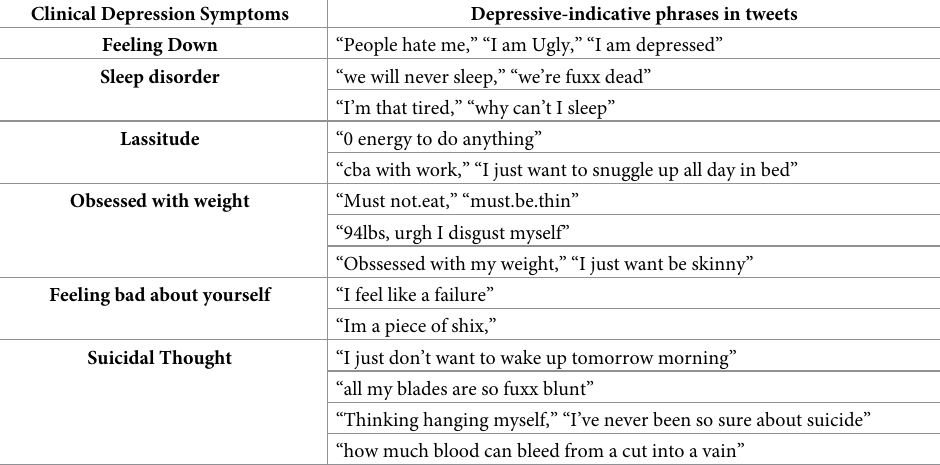
Table 1. Sample of depressive-indicative phrases collected from tweets. Clinical Depression